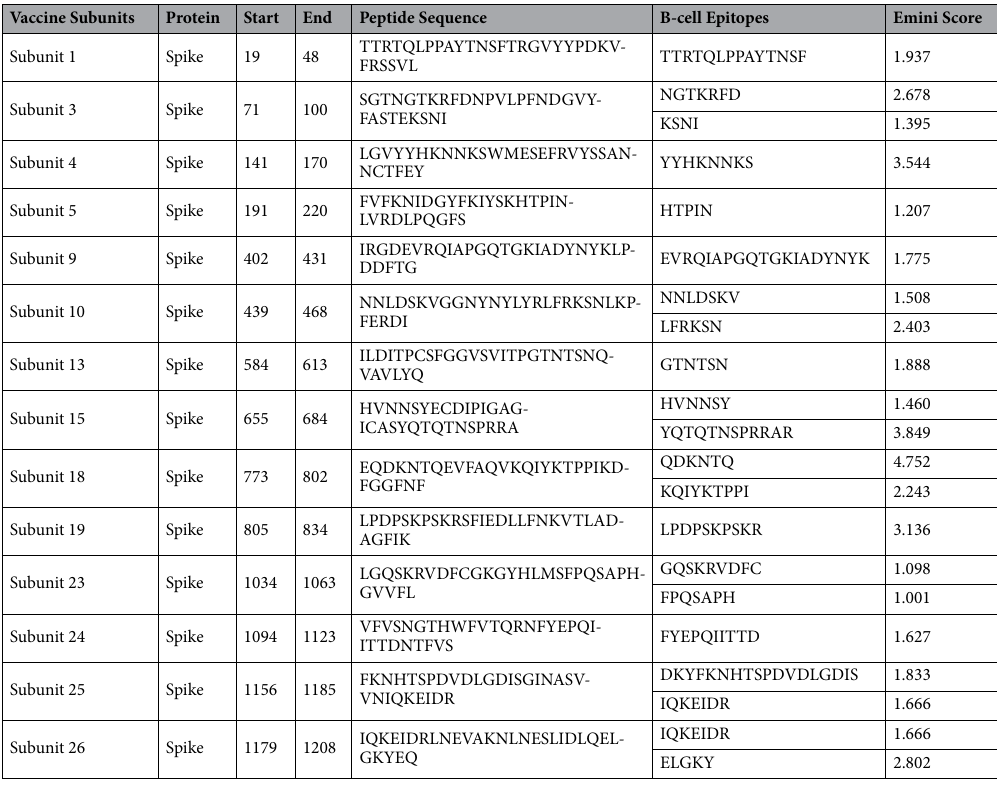
Table 5. Linear B-cell Epitopes Prediction Results. Here, we show the selected 14 vaccine subunits, the contained B-cell epitopes and their Emini